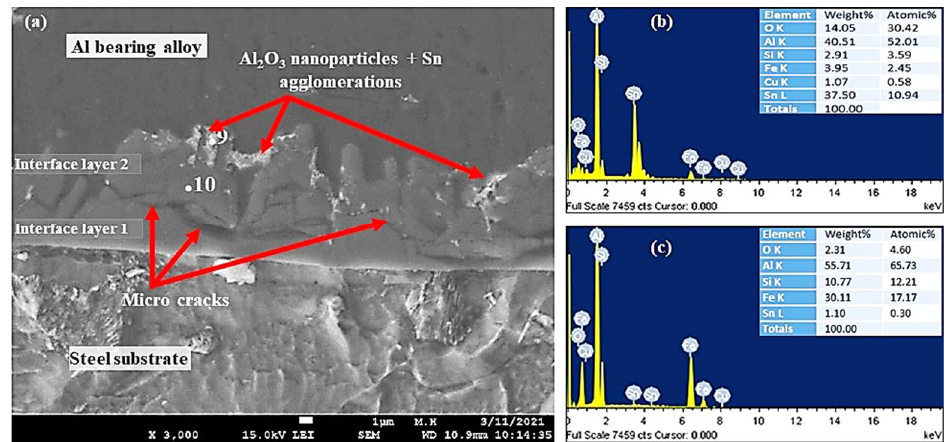
Figure 12. SEM micrographs and EDS from Al-bearing alloy/steel bimetallic composites: ( a ) SEM for bimetal with Sn + 1.50% Al 2 O 3 nanoparticles interlayer (specimen 5); ( b , c ) EDS analysis of points 9 and 10 in ( a ), respectively.